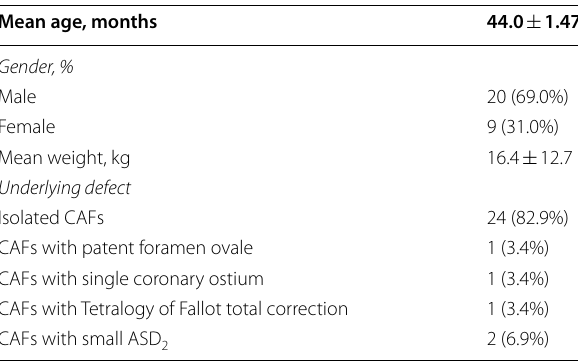
Table 1 Baseline characteristics of study